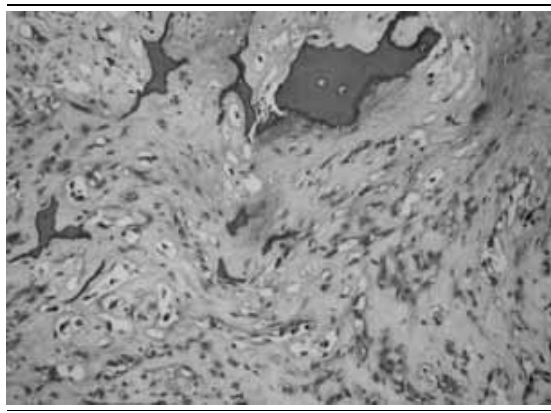
figurE 5 – HEE affecting the bone tissue (HE, 20×) Strings of epithelioid endothelial cells scattered in fibro-myxoid stroma. HEE: epithelioid hemangioendothelioma; HE: hematoxylin and eosin.